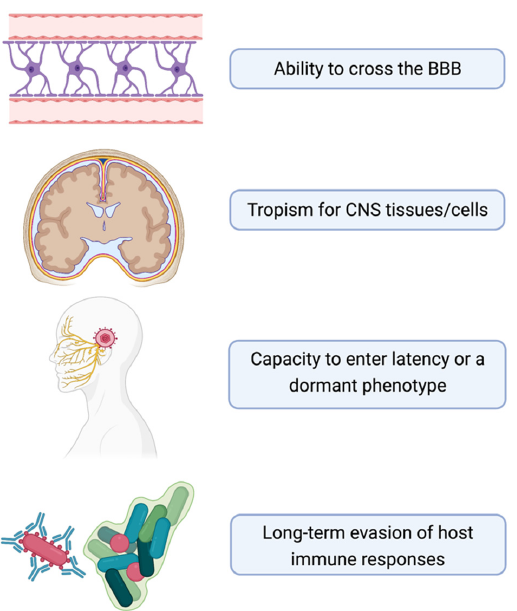
Figure 6. Common characteristics of pathogens implicated in the development of AD.